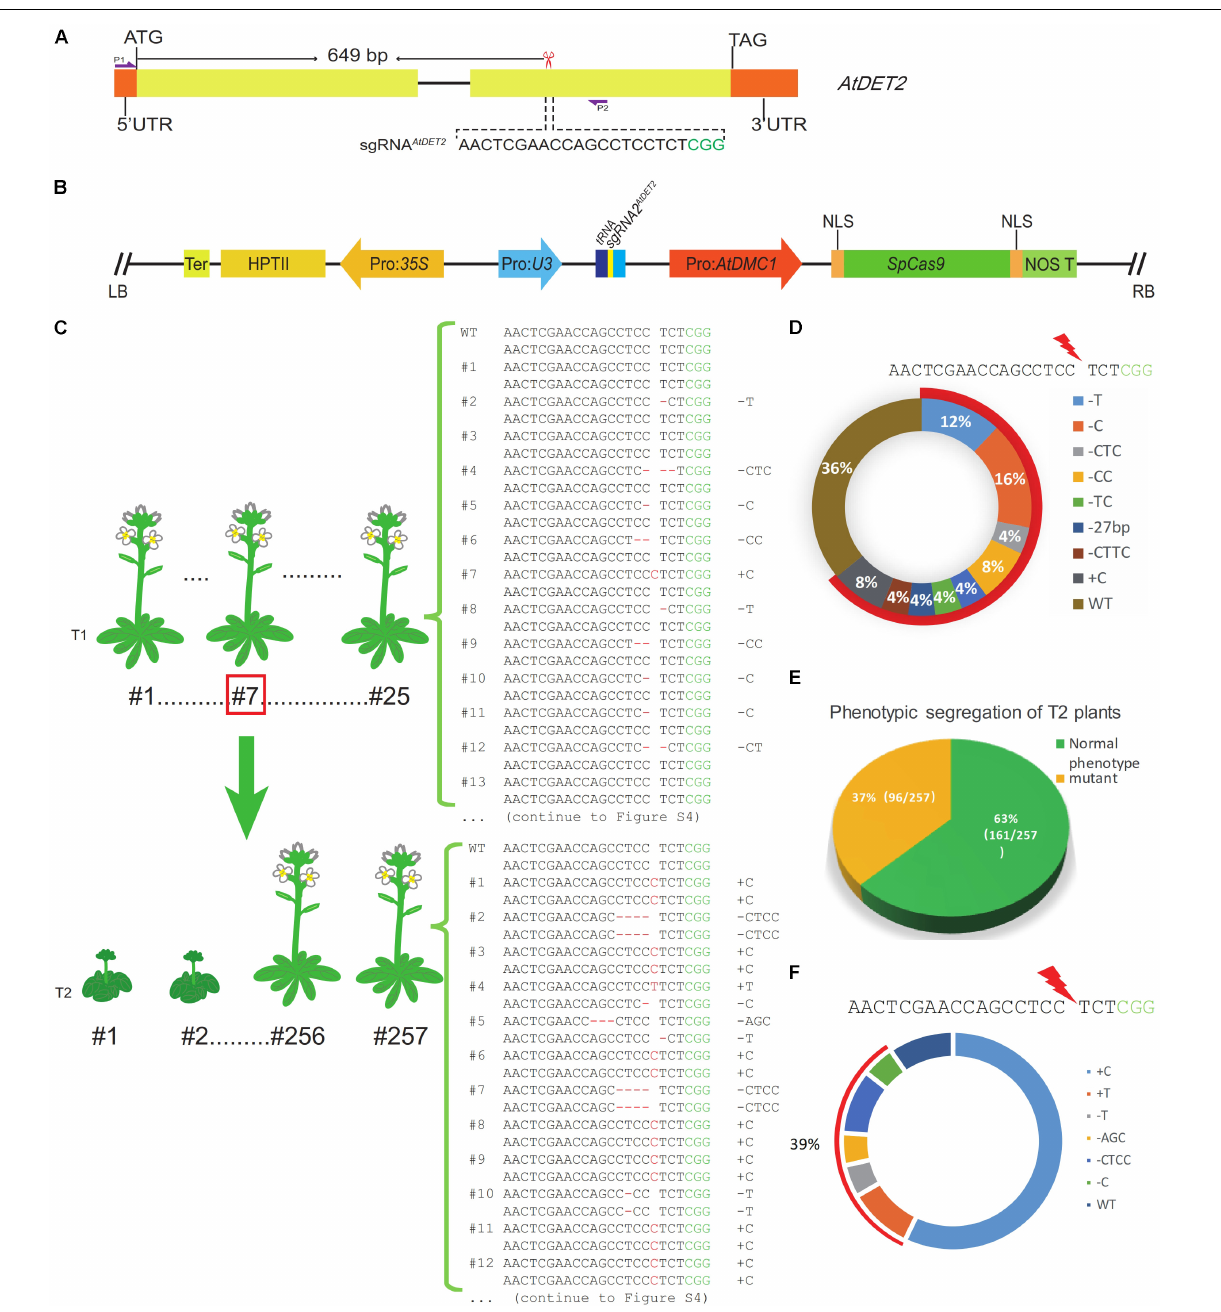
Frontiers in Plant Science |